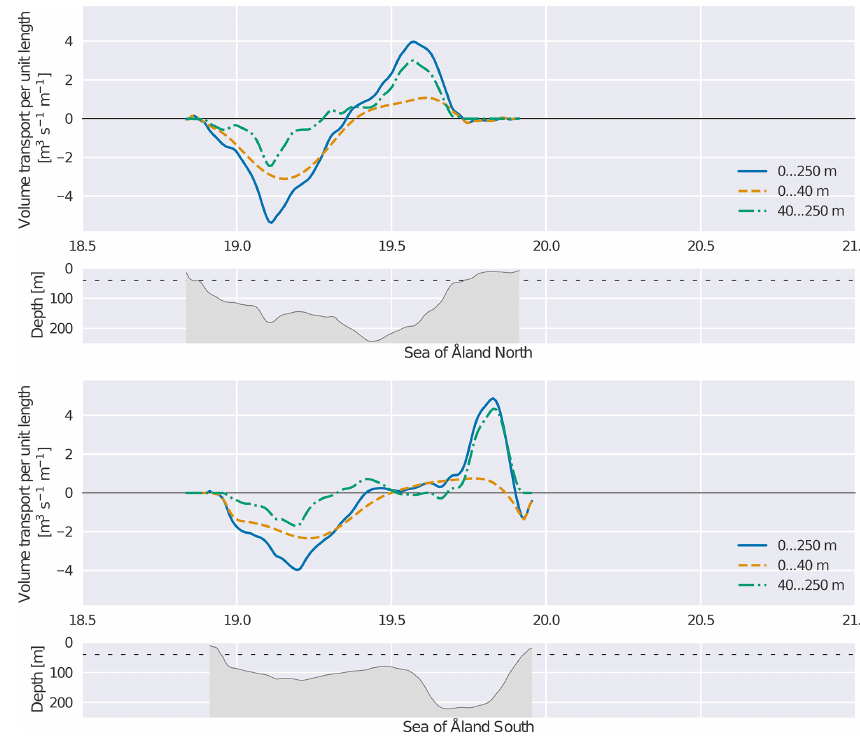
Figure 12. The same as Fig. 11 but for the two transects in the middle part of the Åland Sea (ÅN and ÅS).